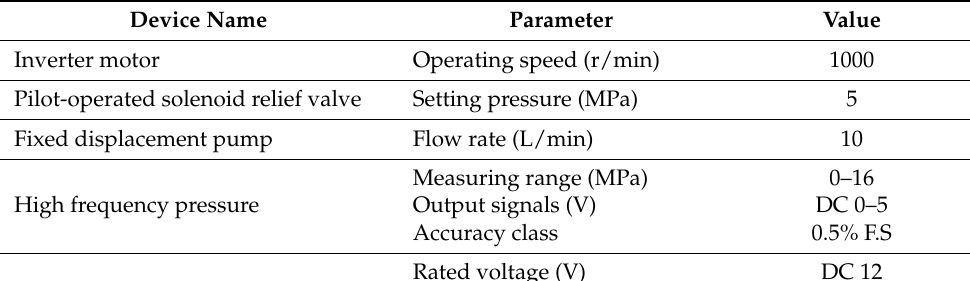
Table 1. Main performance parameters.